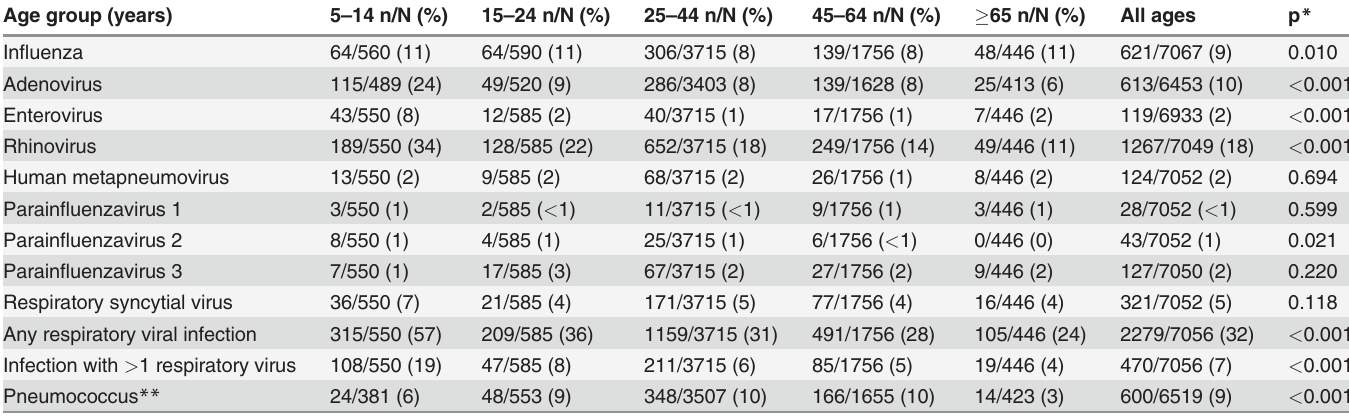
Table 2. Percentage of patients testing positive for viral and bacterial pathogens by age group amongst individuals aged (cid:1) 5 years hospitalised with severe acute respiratory illness (SARI) at four sentinel surveillance sites, South Africa, 2009 – 2012. Age group